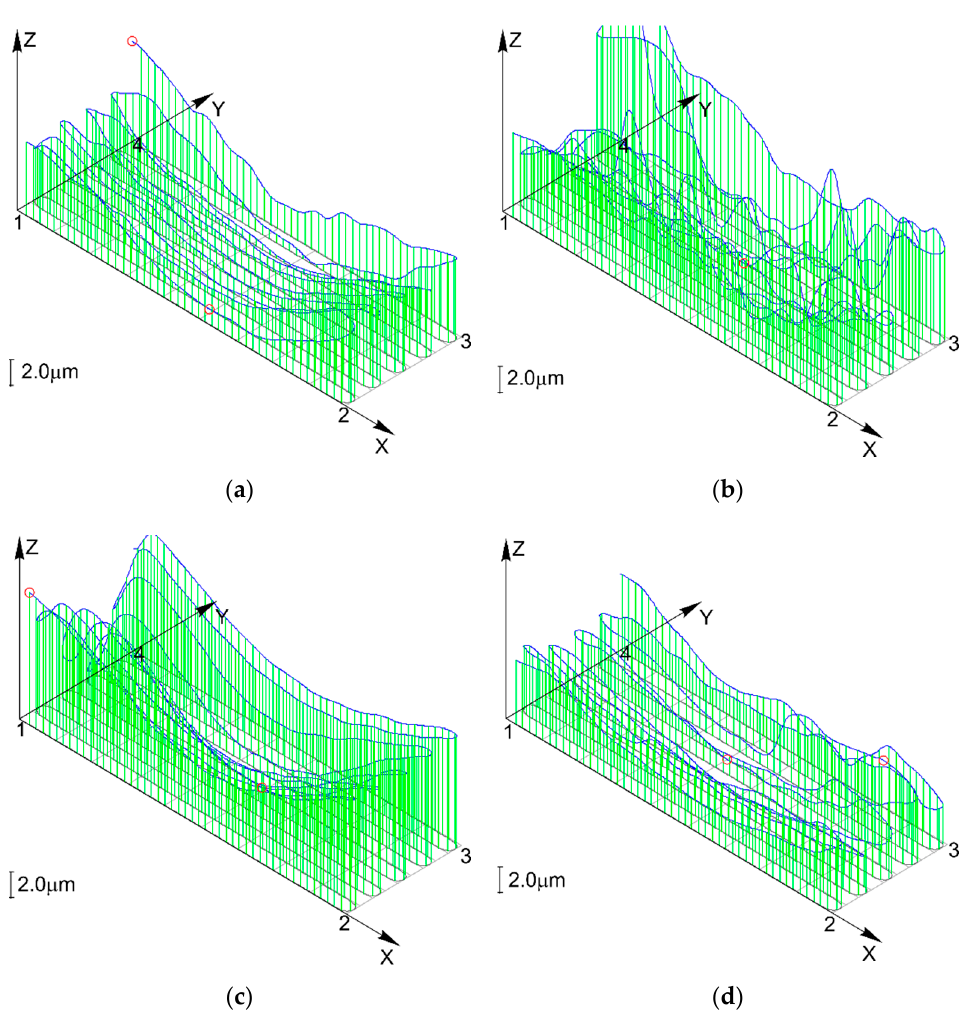
Figure 13. Surface flatness for ( a ) strategy 1, ( b ) strategy 2, ( c ) strategy 3 and ( d ) strategy 4.